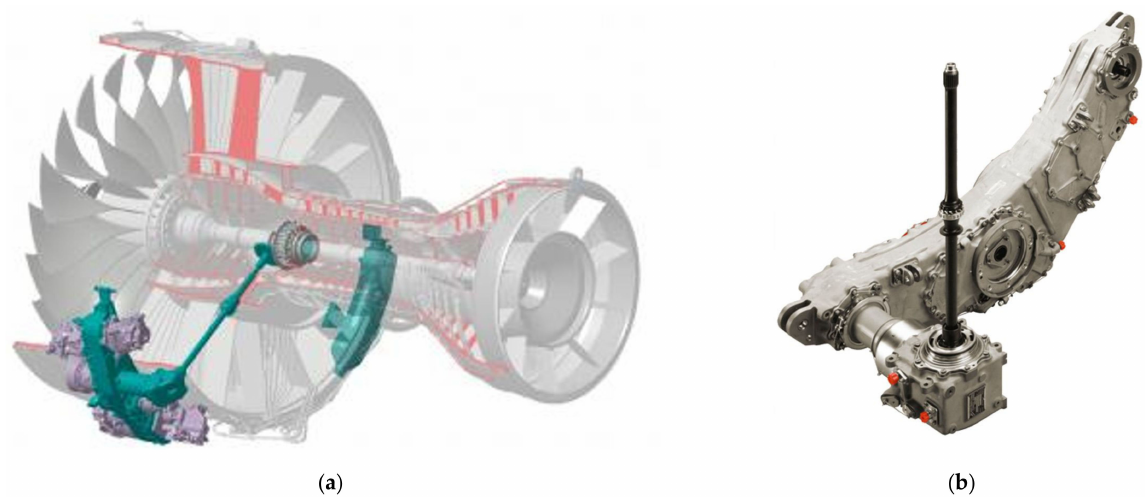
Figure 1. ADT: ( a ) Installation location on an engine; ( b ) actual component overview.